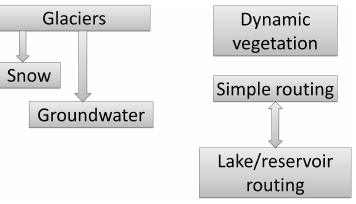
Figure 3. Modules of the SPHY model that can be switched on/off.